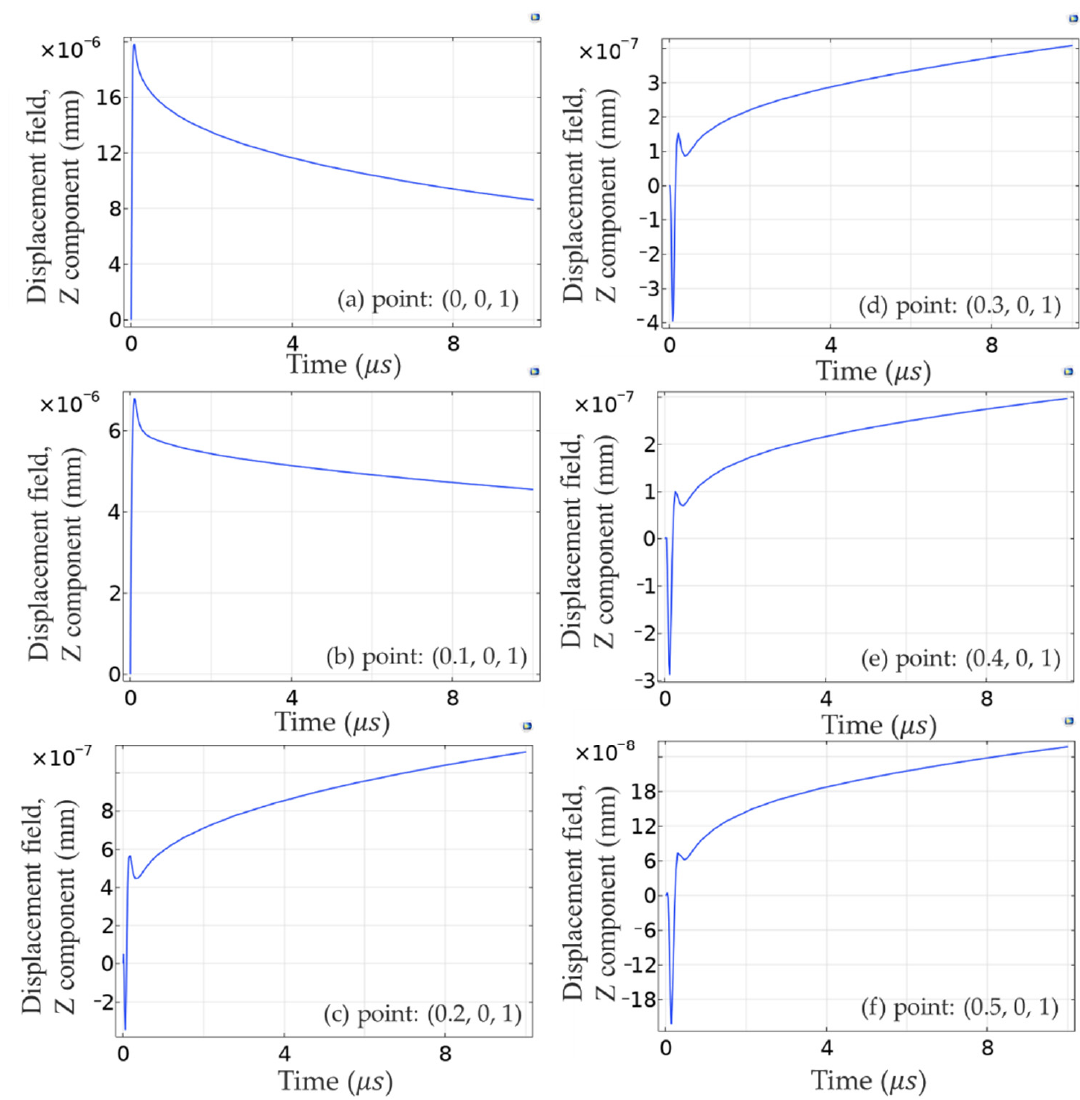
Figure 5. The displacement changes vs. time in different points on the silicon surface on model 1. From Equation (5), it can be seen that the temperature or thermal effect caused a corresponding change in displacement, meaning that they had a proportional relation- ship. Although photoacoustic signals also caused a corresponding displacement, the displacement caused by the thermal effect was far greater than that caused by photoa- coustic pressure within the size range of the laser spot. Therefore, the changing trend of displacement was mainly dominated by the thermal effect within the range of point 0.1 mm. Thus, when using solid mechanics to observe photoacoustic signals in COMSOL, the observation points were all outside the range of the laser spot, and therefore, the influence of temperature on displacement was excluded. However, because of their fast propagation speed, sound waves were observed in a small range of 0.2 mm, but as time passed, the heat also reached this point, indicating that the displacement of the initial part of the curve in Figure 5c strengthened